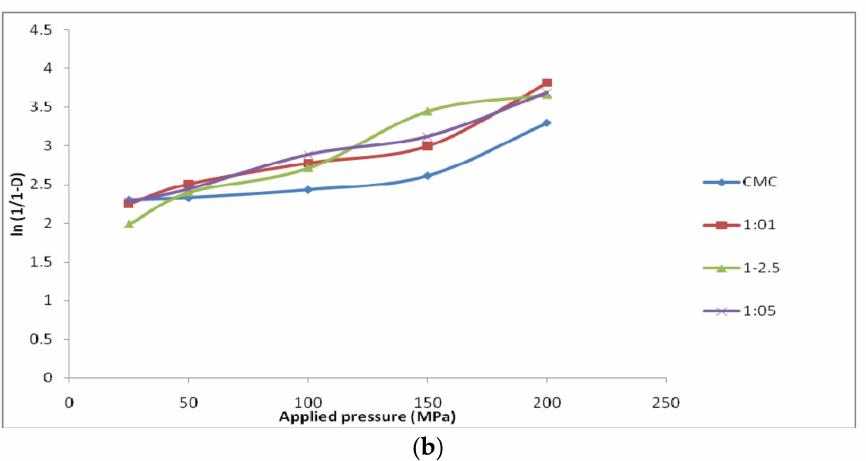
Figure 5. Heckel- Plots for the tablet incorporating ( a ) MCC-SiO 2 conjugates as a super-disintegrant